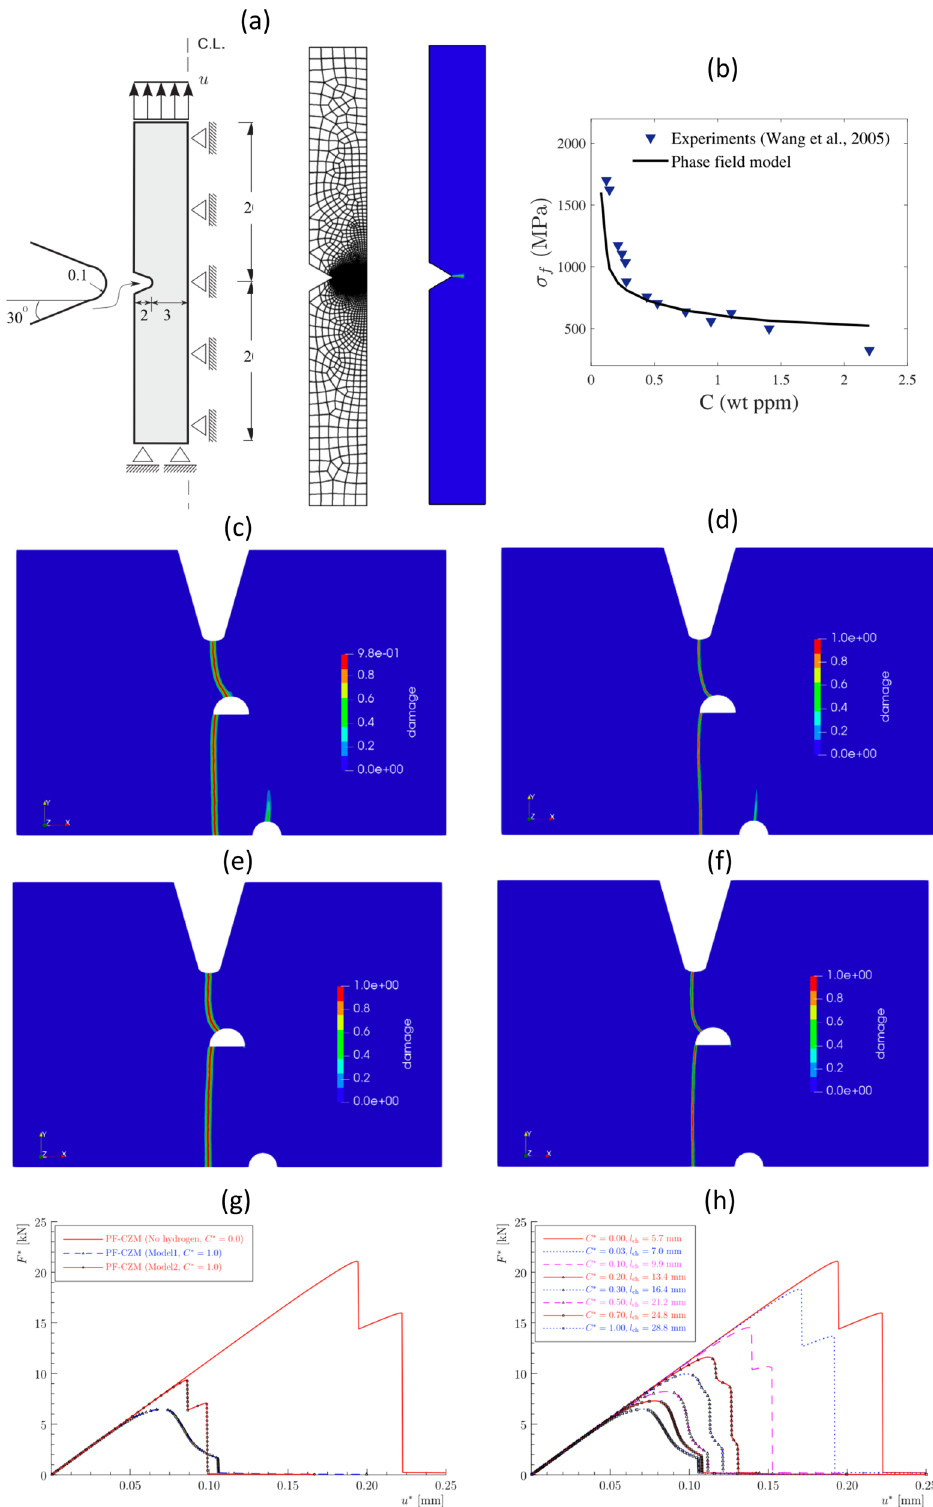
Fig. 9 Hydrogen-assisted cracking. a Schematic description of a notched cylindrical bar subjected to tension. b Comparison of net section strength variation with hydrogen concentration. PF results for a crack pattern under a hydrogen concentration of zero and interface thicknesses of ( c ) 0.4 mm and ( d ) 0.2 mm. PF results for a crack pattern under a hydrogen concentration of 1 wt ppm and interface thicknesses of ( e ) 0.4 mm and ( f ) 0.2 mm. Force and displacement plots for g Model-1 versus Model-2 and h Model-1 at various hydrogen concentrations. a , b are reproduced with permission from ref. 146 , published by Elsevier in 2018. ( c – h ) are reproduced with permission from ref. 147 , published by Elsevier in